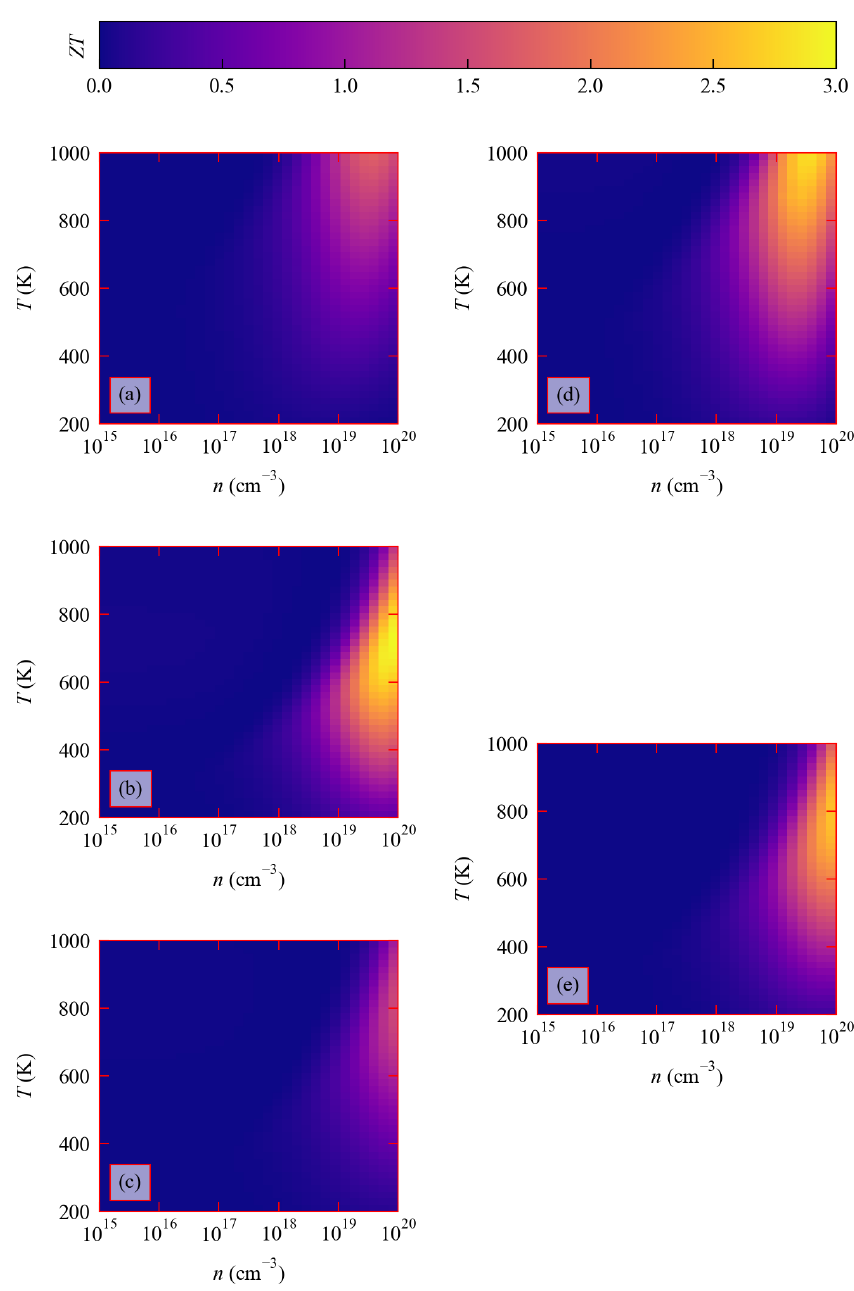
Figure 8. Thermoelectric figures of merit ZT for the Pnma SnS ( a ), equilibrium and compressed rocksalt SnS ( b , c ), Pnma SnSe ( d ), and rocksalt SnSe ( e ) calculated using Equation (1) as a function of carrier concentration n and temperature T